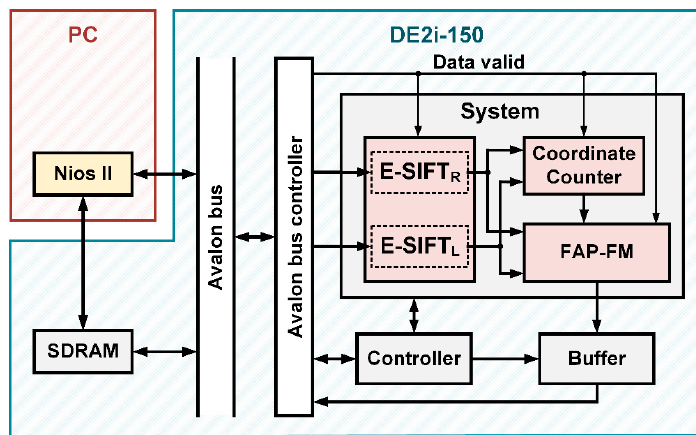
Figure 24. Architecture of the proposed stereo vison system .